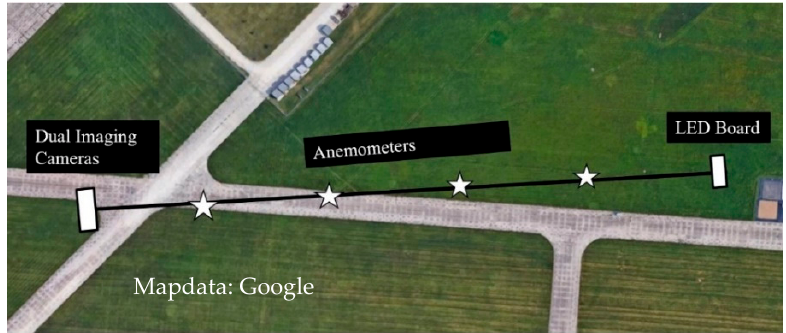
Figure 4. Long-range experimental setup. Stars denote the location of the anemometers.